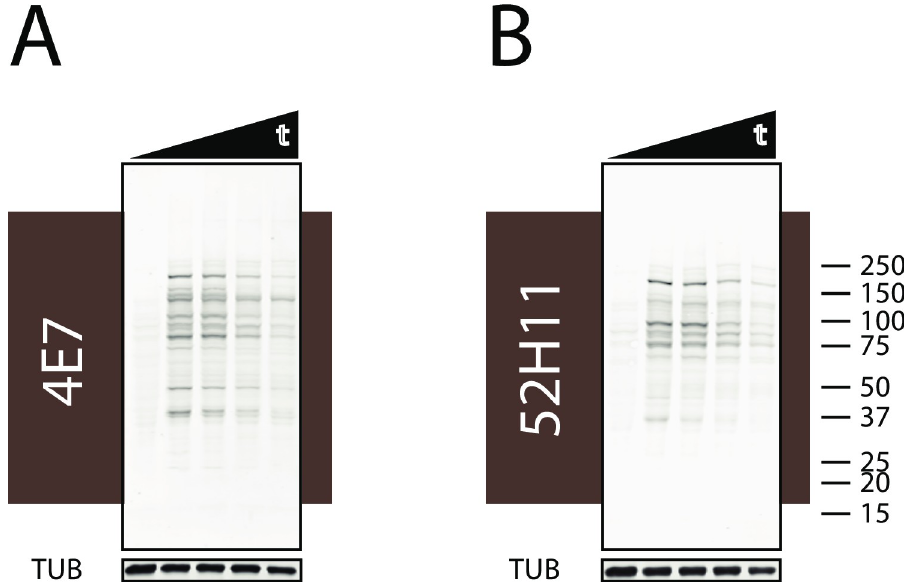
Fig 5. Detection of protein CAM-cys after pulse chase labeling of living cells with IAM. IAM (1mM) was added to growth media of 293 cells for 2 minutes followed by media without IAM for defined periods of time. Chase time intervals (lanes marked by triangle t) were 0, 8, 24, and 32 hours. Cells were collected for analysis of labeled protein content by Western blotting with 4E7 (A) and 52H11 (B). Western blotting for tubulin (TUB) served as a control for total protein